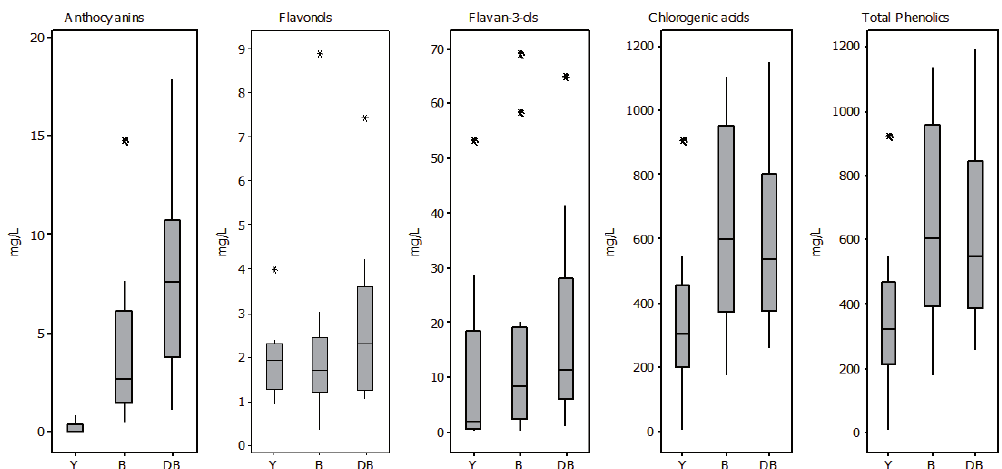
Fig. 2: Box plots of total phenolic contents (mg/L), total hydroxycinnamic acids, total flavan-3-ols, total anthocyanins, and total flavonols in juices of plum varieties with yellow (Y), blue (B) and dark blue (DB) skin. Quantification was performed by HPLC and the individual components were summed up for getting the corresponding total values. Respect the different scales. The box plots show the meridian (horizontal line), the interquartile range box between the first and the third quartile, and outliers (asterisk). The upper and lower whiskers extend to the highest and lowest data value,